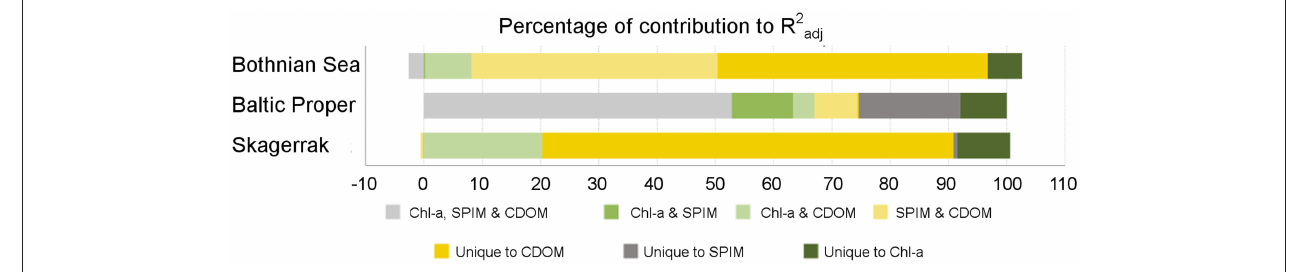
FIGURE 2 | Bar chart of the commonality analyses based on the main empirical GLMs (see Table 3 ). The separated commonalities are presented as % of the contribution to the R 2 adj for each model.